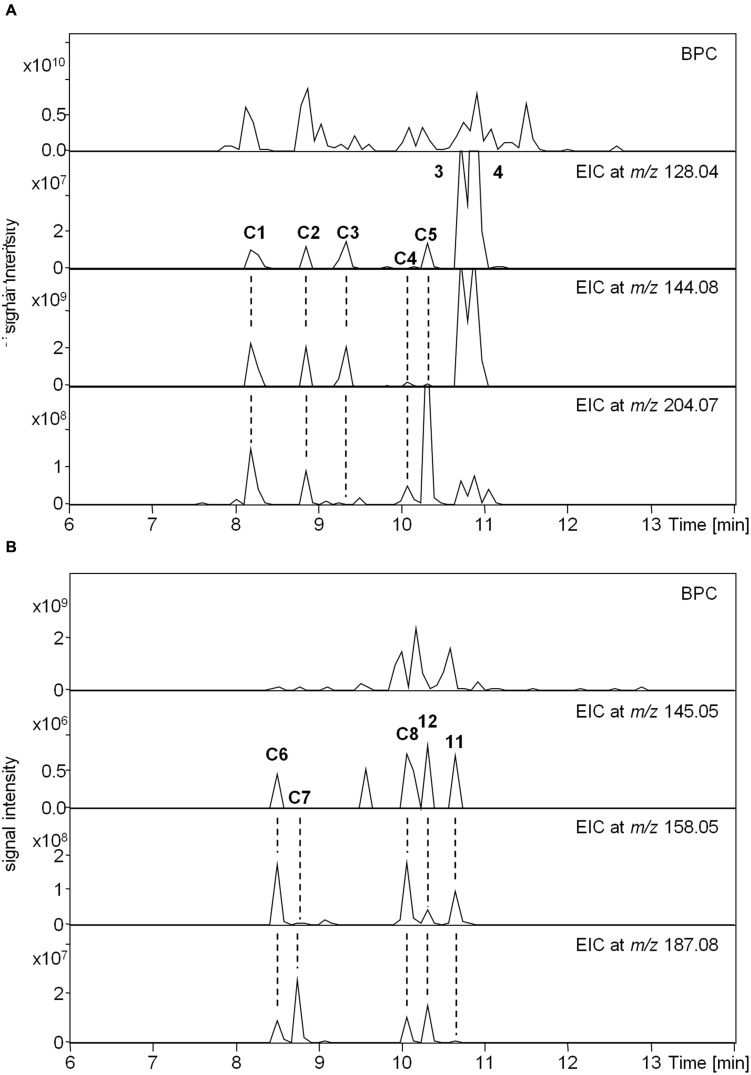
Targeted metabolome analysis using the MS/MS boost analysis. Candidates of indole and oxindole compounds are shown as “C.” (A) Upper panel, base peak chromatogram (BPC) in the Catharanthus roots. Lower panels, extracted ion chromatogram (EIC) at m/z 128.04, 144.08, and 204.07 assigned as C9H6N, C10H10N, and C15H10N, respectively. (B) Upper panel, BPC in the Uncaria hooks. Lower panels, EIC at m/z 145.05, 158.058, and 187.08 assigned as C9H7NO, C11H11N2O, and C10H8NO, respectively.